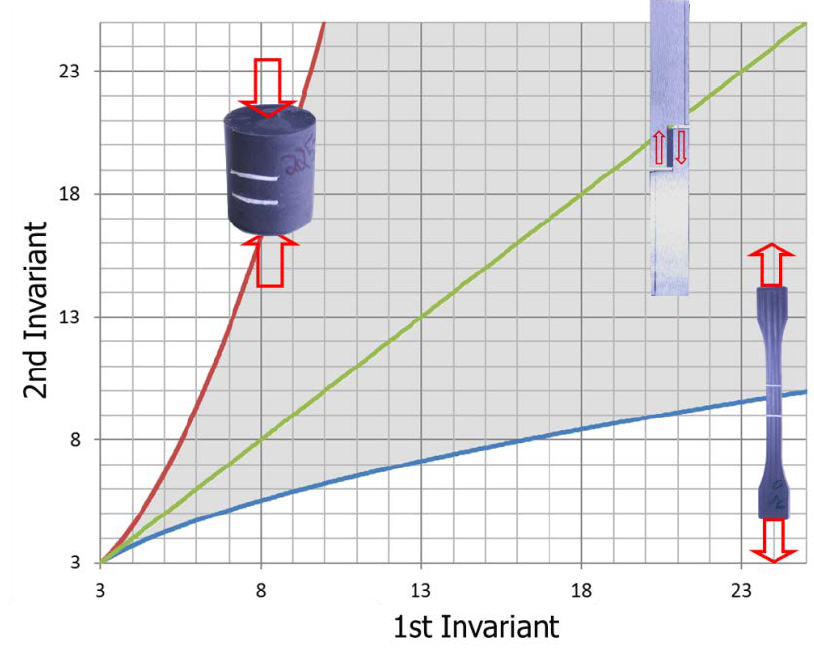
Fig. 2 2 nd over 1 st invariant for the three performed tests and possible deformations in grey. see also (Treloar 1975, Vöhringer 2009, Baaser 2010, Weiß et al.